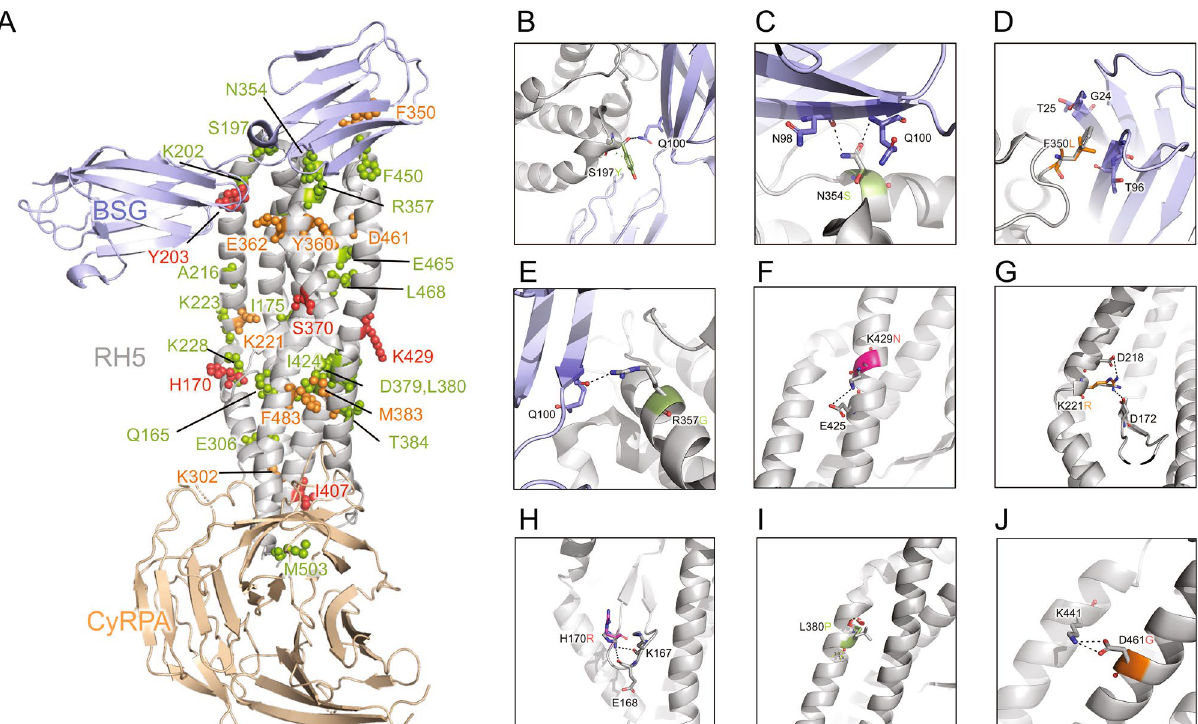
Figure 4. Structure-function predictions for novel SNPs identified in PfRh5 ( A ) Location of SNPs in the BSG– RH5–CyRPA complex. The complex was built by superposing the RH5 of RH5–BSG complex (PDB id: 4U0Q) and RH5–CyRPA complex (PDB id: 6MPV). BSG, RH5 and CyRPA are shown by light blue, grey and light orange, respectively. ( B – J ) Small panels highlight the predicted effect of selected SNPs, the black dotted lines represent hydrogen bonds or salt bridges. From top-left to bottom-right: SNPs that potentially impact binding of PfRh5 and BSG ( B – E ); S197Y, N354S, F350L, R357G), SNPs that potentially alter the structure of PfRh5 ( F – J ; K429N, D461G, L380P, H170R, K221R). SNPs reaching significance above the 1% discovery threshold are color coded according to frequency in individual samples with low frequency < 2% (green), intermediate frequency 2–25% (orange), high frequency > 25%